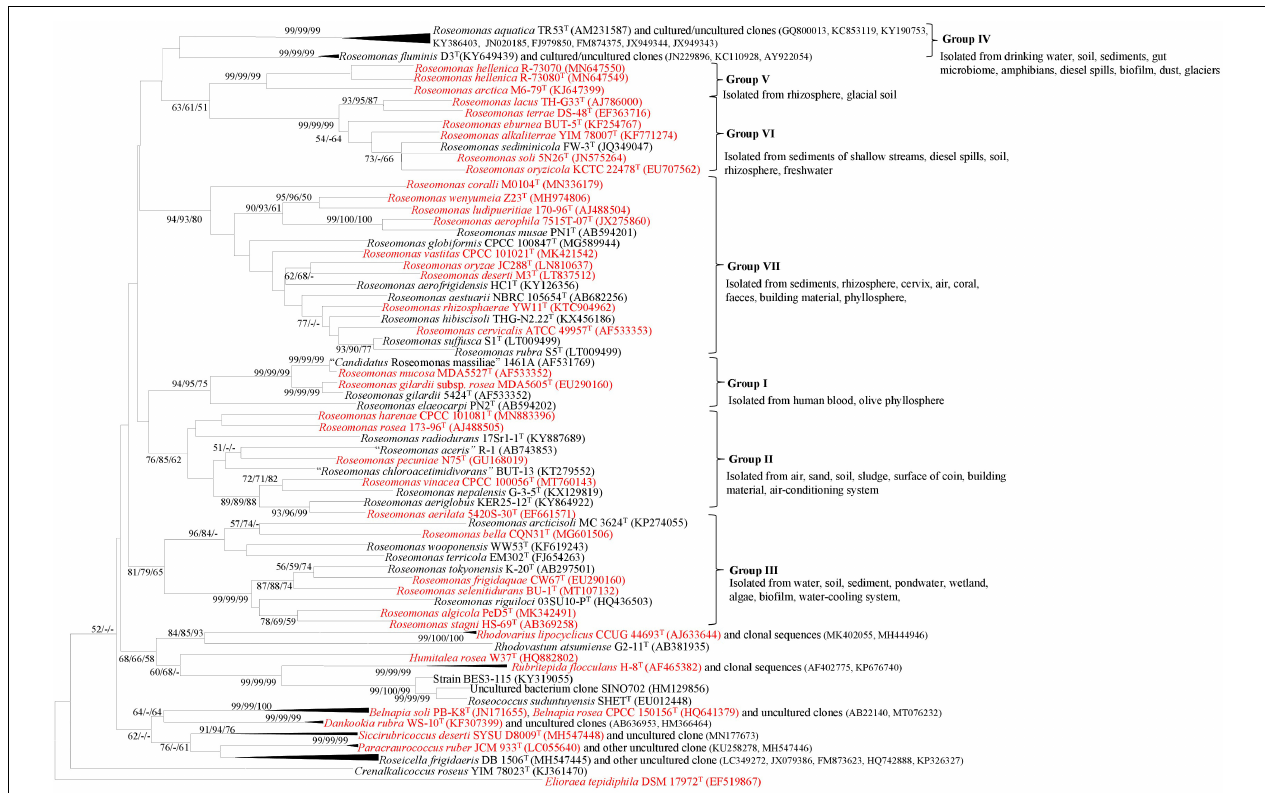
FIGURE 1 | NJ phylogenetic tree based on the 16S rRNA gene sequences showing the phylogenetic relationship between the members of the genus Roseomonas and other closely related members of the family Acetobacteraceae . Elioraea tepidiphila DSM 17972 T was used as an outgroup. Numbers at nodes represent bootstrap values (given as percentages of 1,000 replications) of > 50% shown at branch points (NJ/ML/ME). The GenBank accession numbers for the 16S rRNA gene sequences are shown in parentheses. Bar, 0.01 accumulated changes per nucleotide substitutions (red color indicates the availability of their genomes).